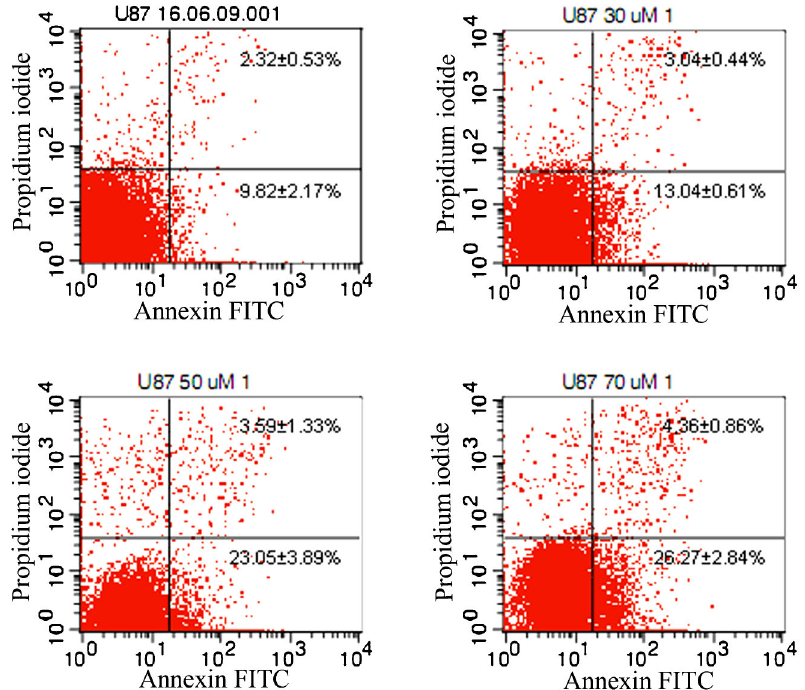
Figure 3. Kaurenoic acid (KA) induces apoptosis in U87 cells. U87 cells were treated with 30, 50, or 70 m M KA for 48 h. Phosphatidylserine (PS) externalization was determined by the combined annexin V/propidium iodide (PI) assay. Cells that stained positive for annexin V represented cells with intact membranes and externalized PS (percentages are indicated in the lower right panel). Cells that stained positive for annexin V/PI represent cells that had lost membrane integrity (percentages are indicated in the upper right panel). Data are reported as means ± SD of 3 determinations. P , 0.05 for 70 and 50 m M KA treatment vs control (Bonferroni multiple comparison